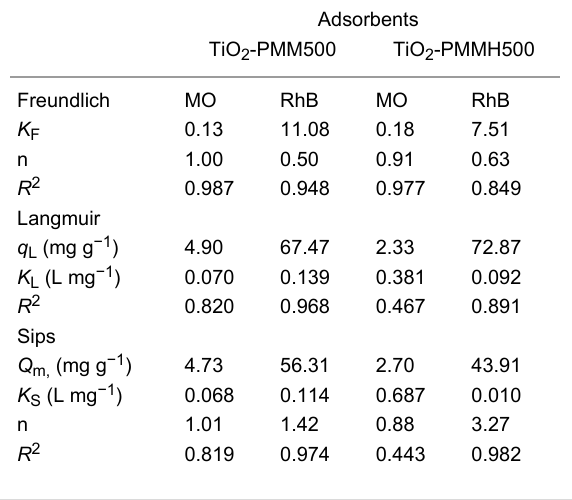
Table 7: Freundlich, Langmuir and Sips constants for MO and RhB adsorption. Adsorbents TiO 2 -PMM500 TiO 2 -PMM Н